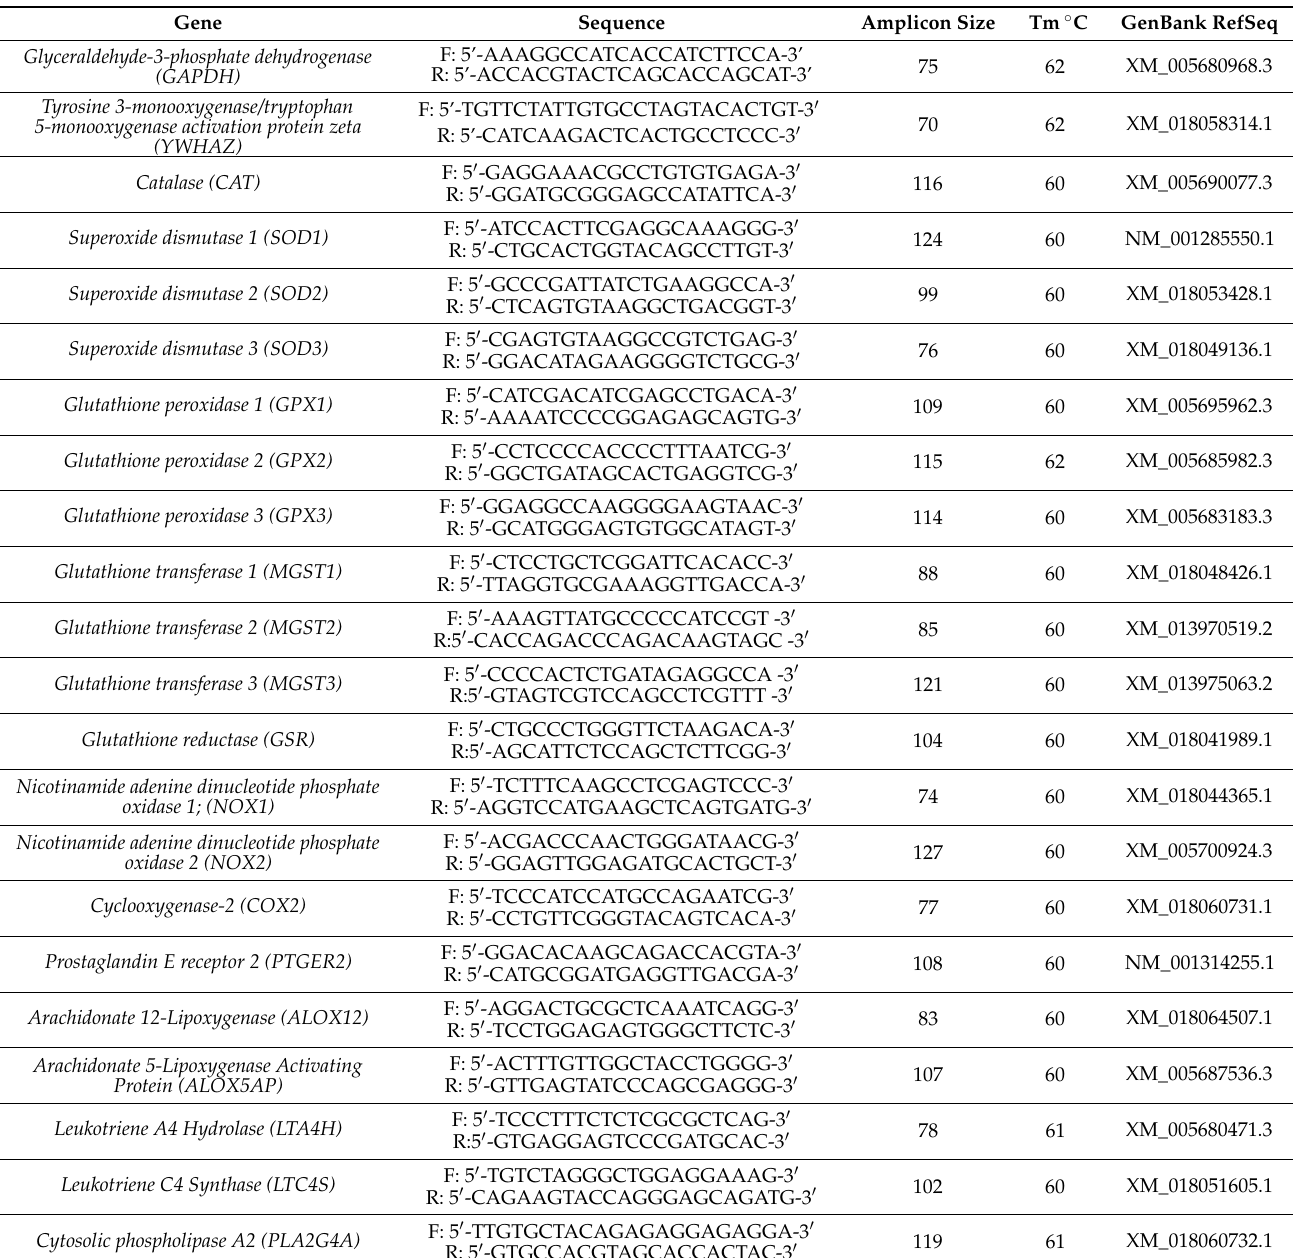
Table 1. Sequences, amplicon size, annealing temperature, and RefSeq number of primers used in real-time